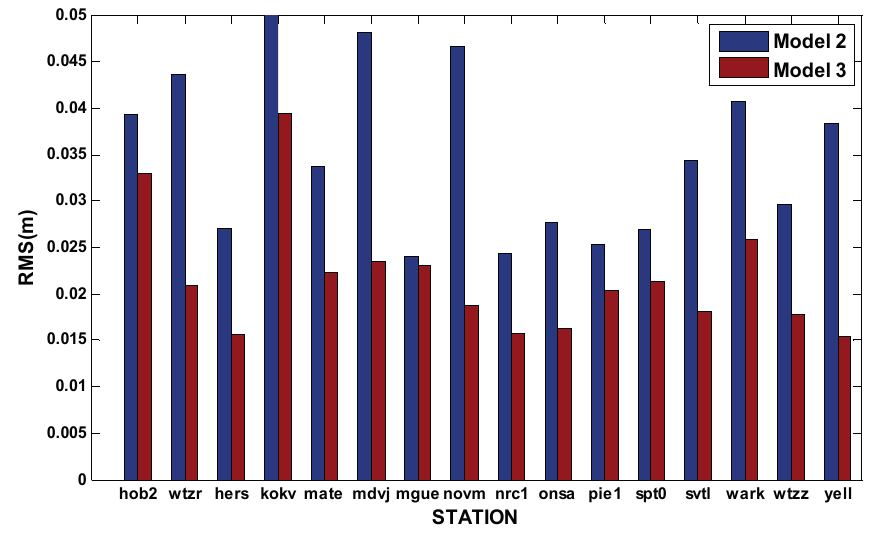
Figure 4. The STDs and RMSs of the kinematic GPS/GLONASS PPP (Model 2 vs. Model 3).